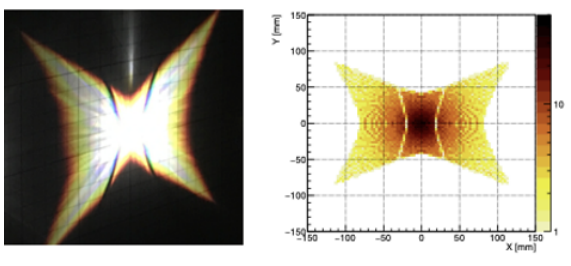
Figure 11. Left: The unique shape of spot of CRAFFT detector. Right: Simulated spot shape. The shade of the lens support can be seen in the simulated spot and actual spot.